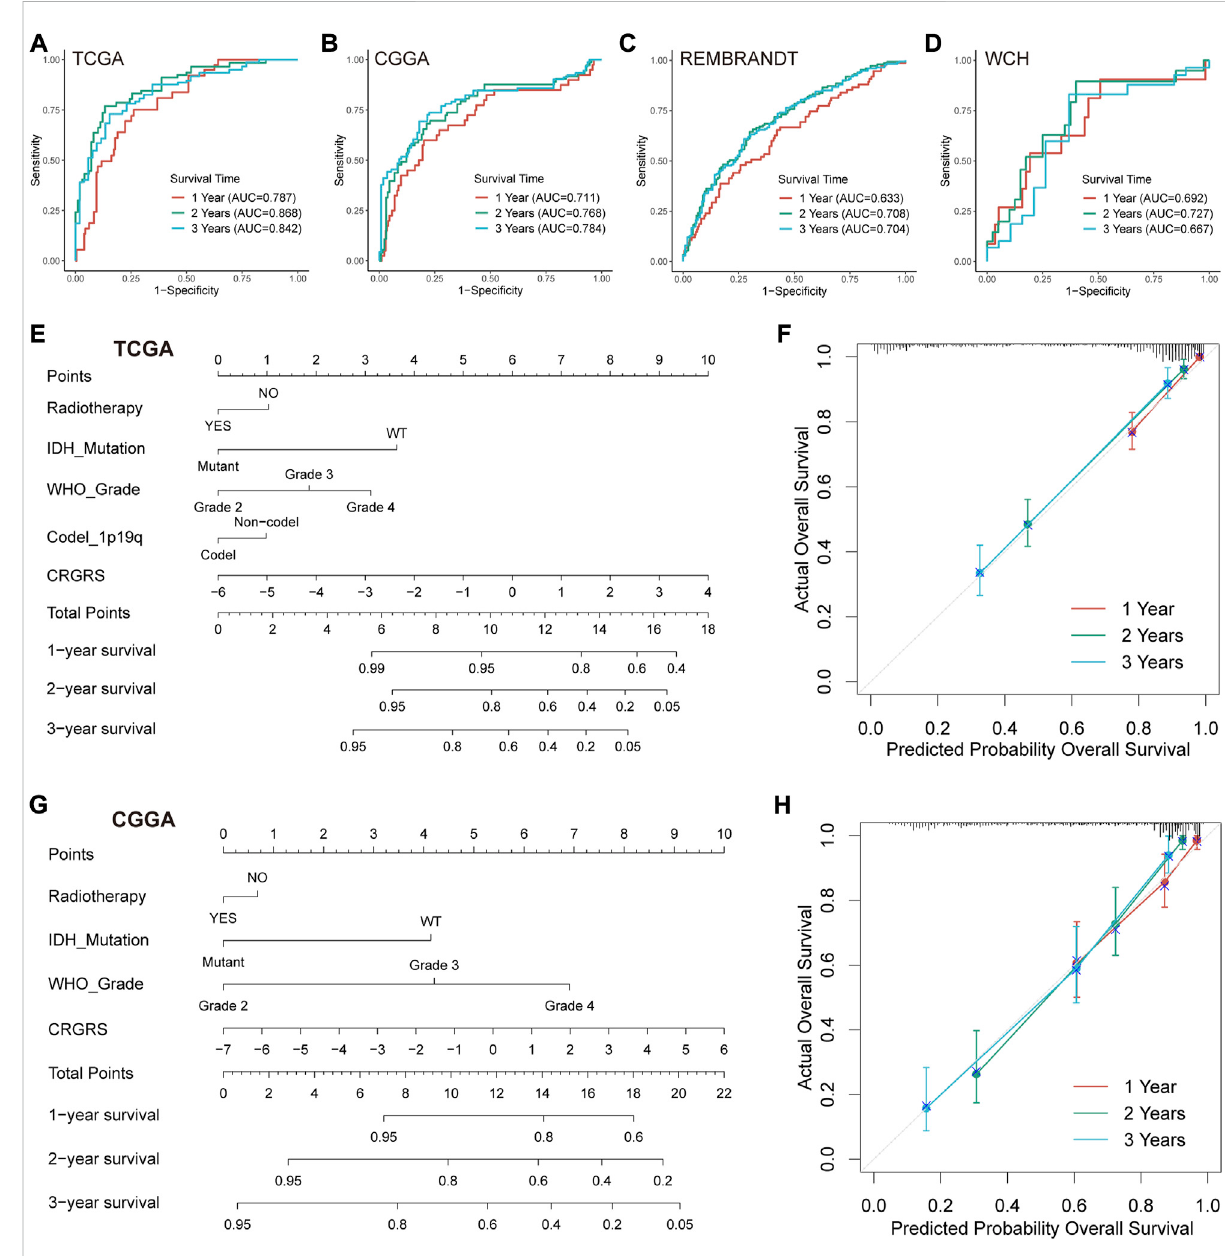
FIGURE 8 PrognosticvalueofCRGRS andconstructionofaCRGRS-basednomogram.ROC curves andmatchedAUC of1-,2-,and 3-yearssurvivalin